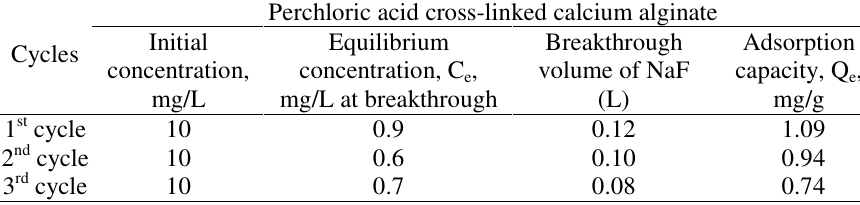
Table 2. Percentage desorption data of fluoride adsorbed on